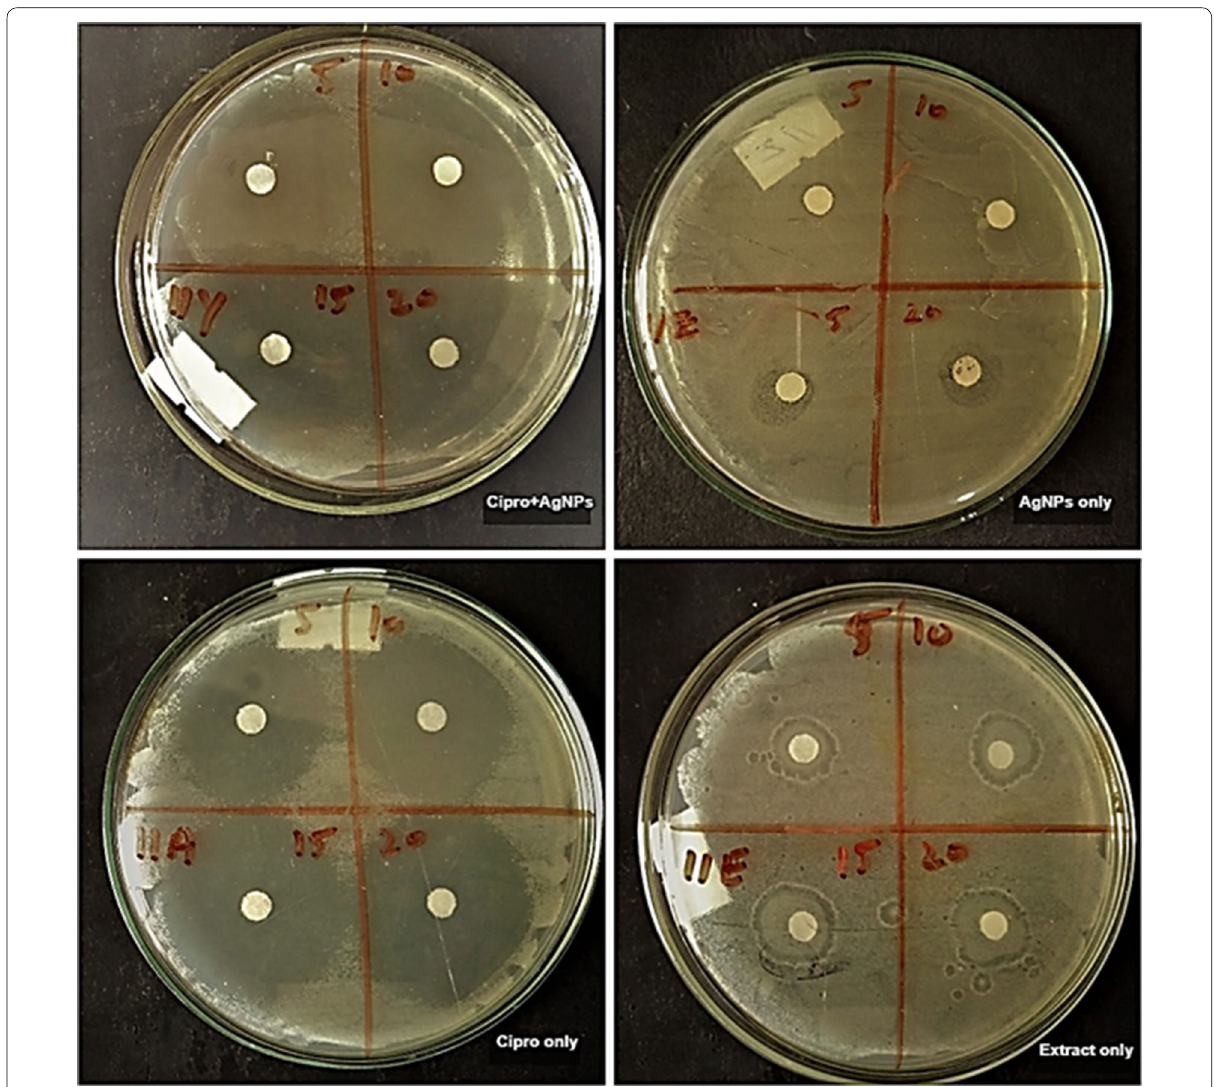
Fig. 7 Activity of ciprofloxacin callus extract mediated AgNPs, callus extract mediated AgNPs, ciprofloxacin only and callus extract only controls + against Salmonella